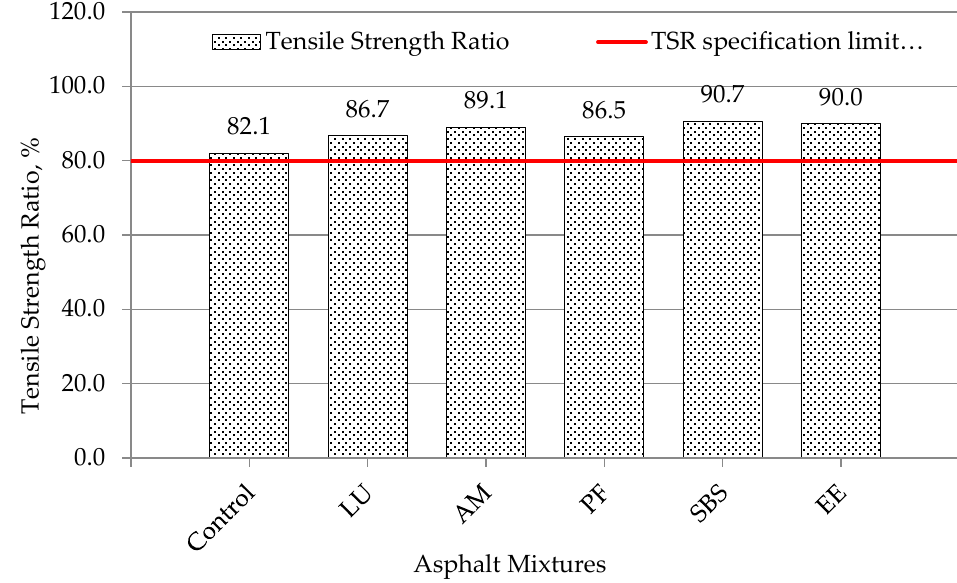
Figure 12. Tensile strength ratio for different mixtures.